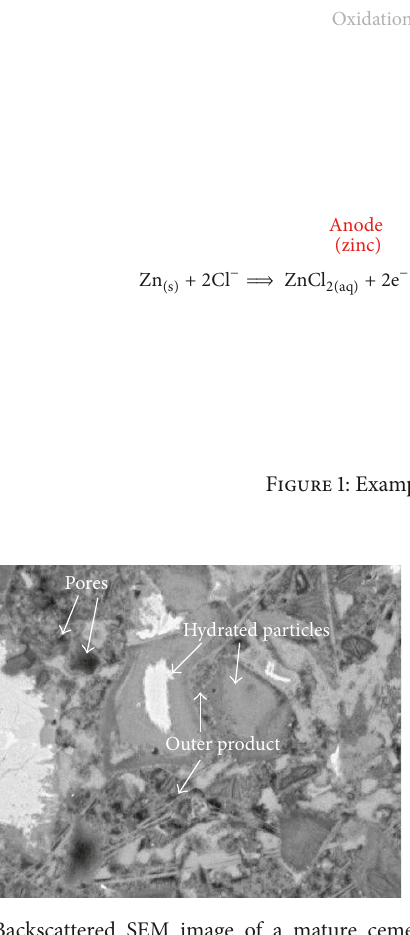
Figure 2: Backscattered SEM image of a mature cement paste showing the main microstructural features [9].